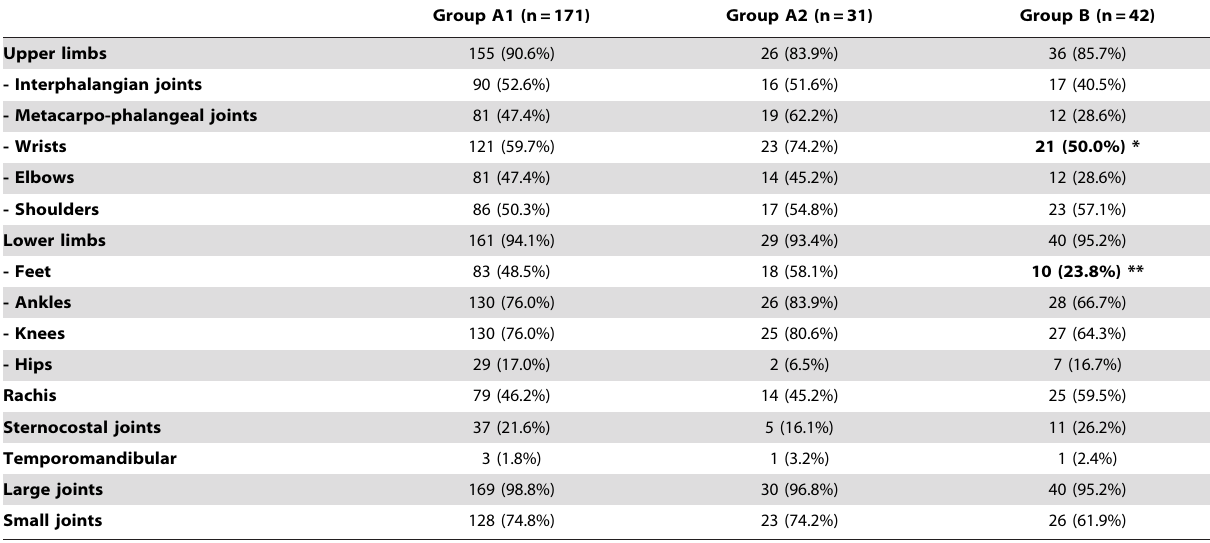
Table 3. Arthralgia location.